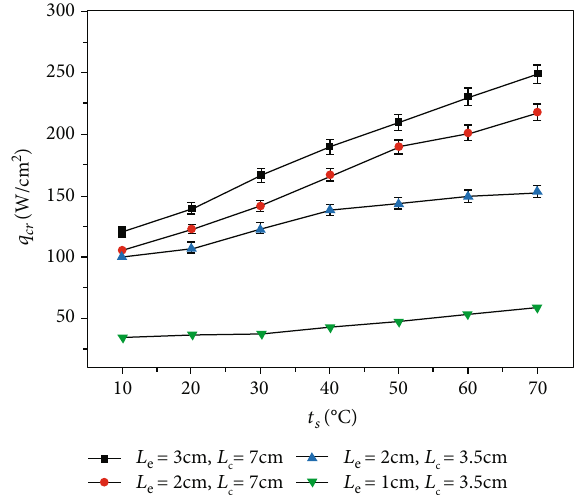
ff ect of cooling temperature on operating